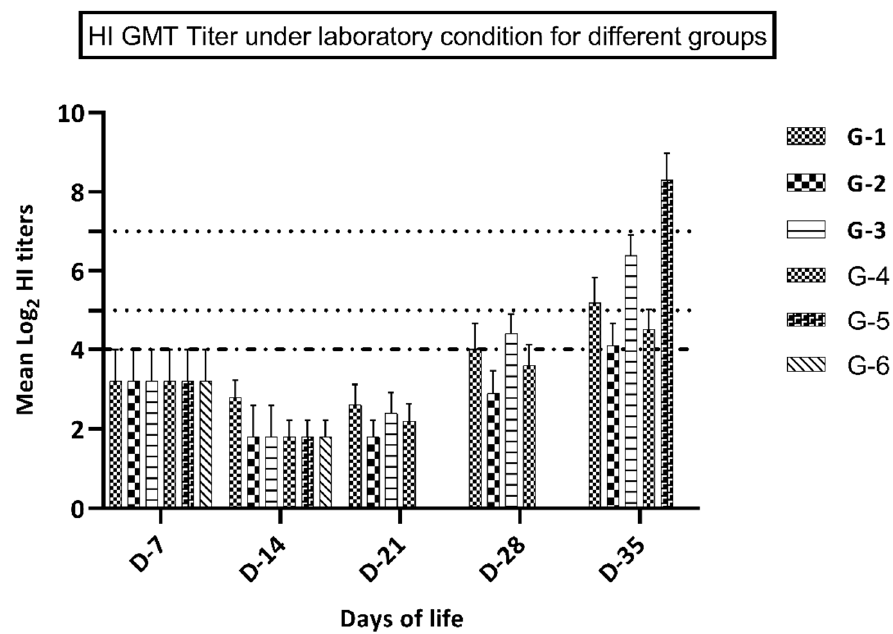
Figure 1. GMT of HI titers in groups 1-6 (kept under laboratory conditions).